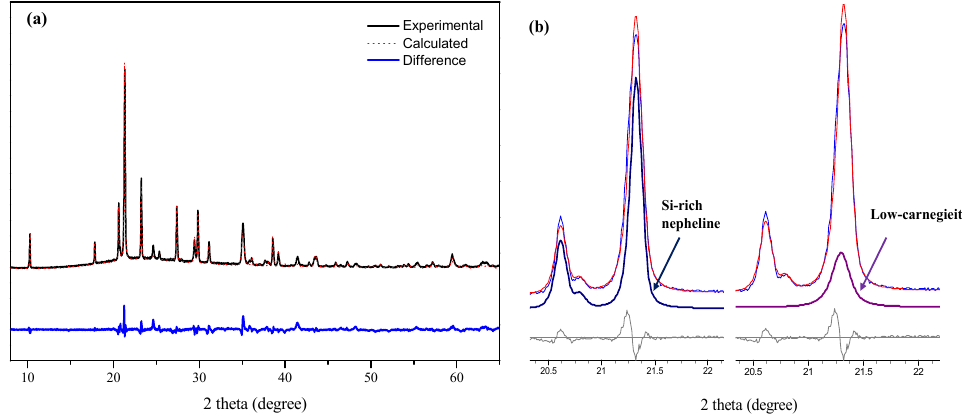
Figure 5. Rietveld refinement result of pure geopolymer heat treated at 900 °C ( a ); the crystal information of Si-rich nepheline and low-carnegieite was refined. The overlapped diffraction pattern of Si-rich nepheline and low-carnegieite was confirmed at 2 θ 21.2° ( b ).